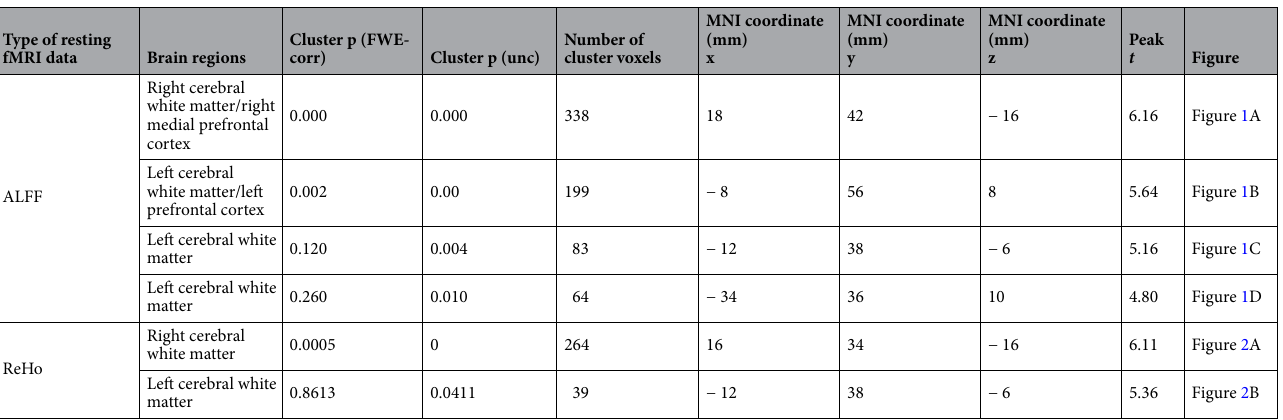
Table 2. Resting fMRI data summary. Brain regions with cluster FWE-corrected p < 0.001 showing significantly higher regional neuronal activity (ALFF and ReHo) in patients with perinatally afflicted HIV (n =